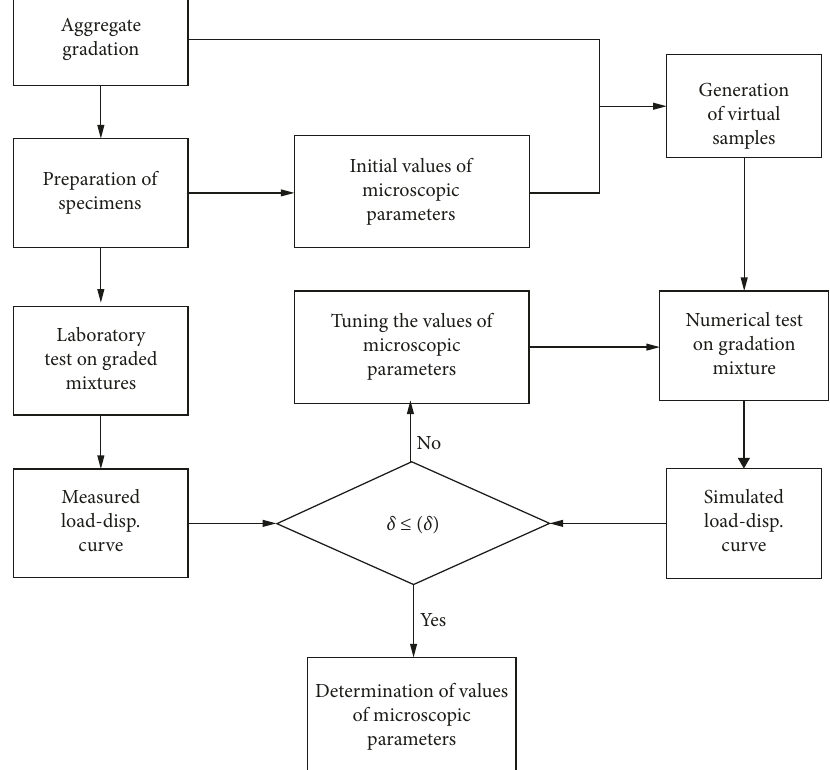
Figure 3: Method of determining the values of microscopic parameters of graded aggregates.